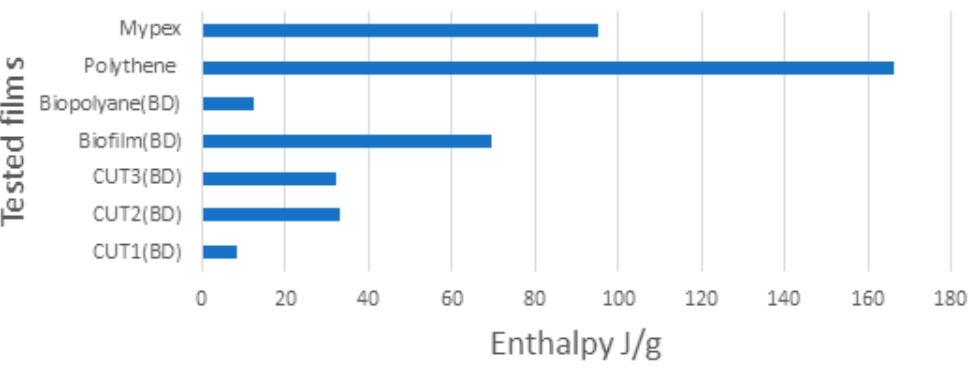
Figure 7. Total enthalpy of exothermic changes taking place in the studied samples.